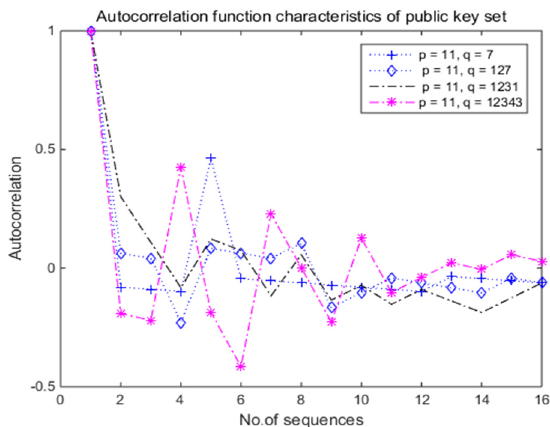
Figure 4. Autocorrelation function characteristics of 16-bit public key set in relation to prime numbers ( p , q ) = ( 11, 7 ) , ( 11, 127 ) , ( 11, 1231 ) , and ( 11, 12,343 ) .